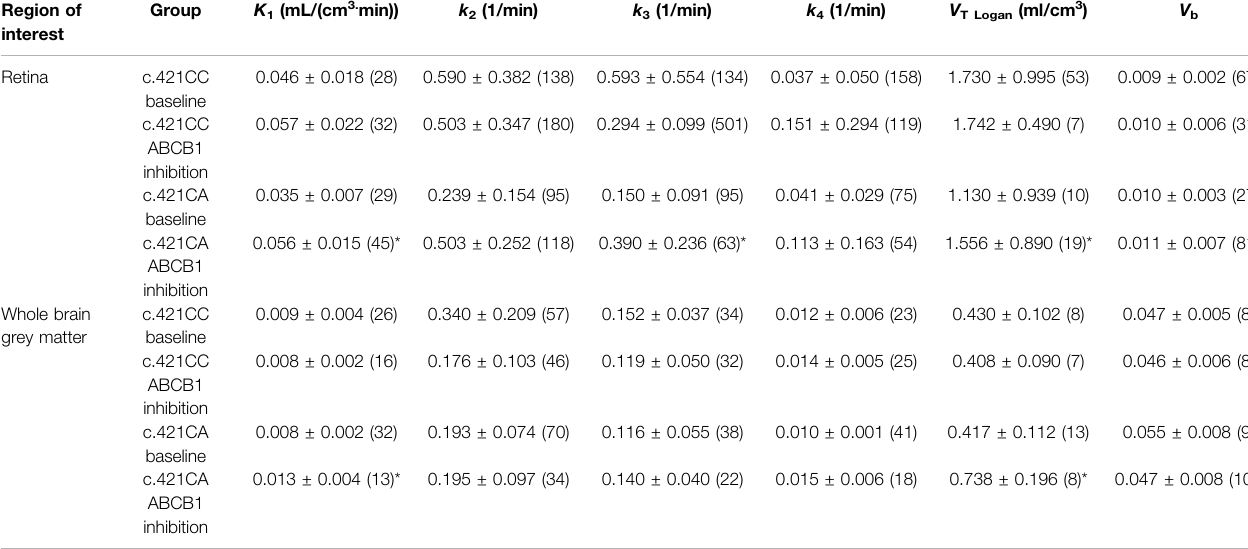
TABLE 1 | [ 11 C]Tariquidar modelling outcome parameters for the retina and whole brain grey matter in c.421CC and c.421CA subjects for the baseline scan and the scan during ABCB1 inhibition with unlabelled tariquidar. Region of